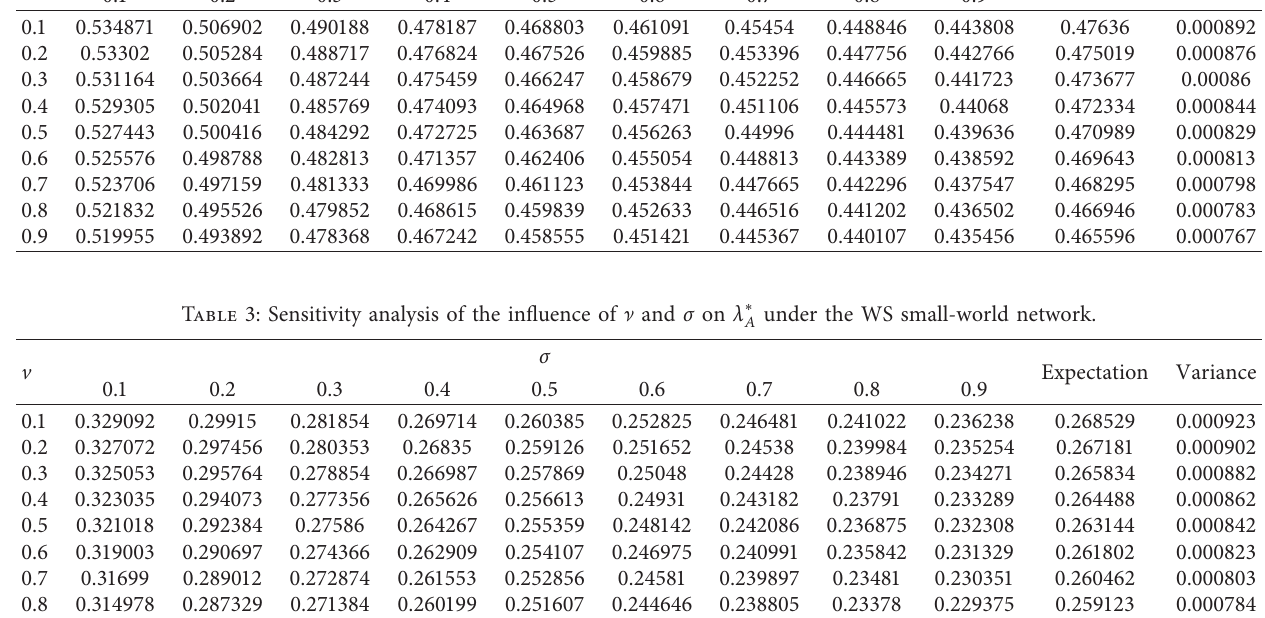
A under the index network.